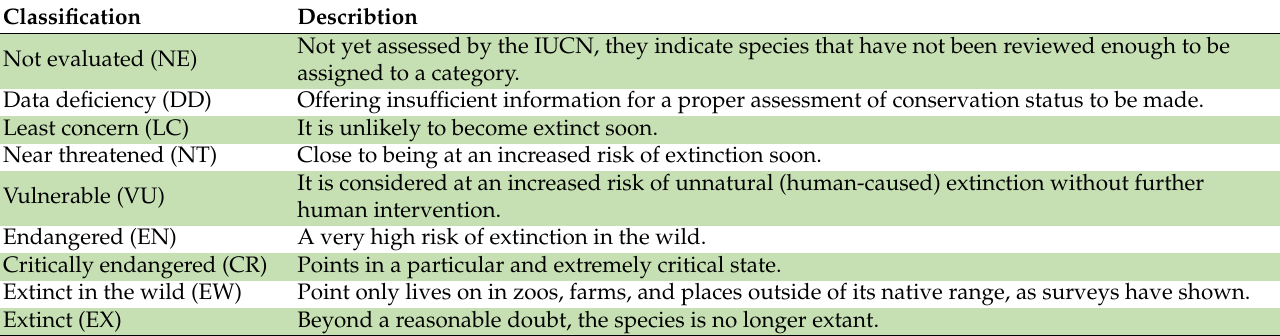
Table 2. The IUCN Red List classifies species into nine groups [19,100,103].